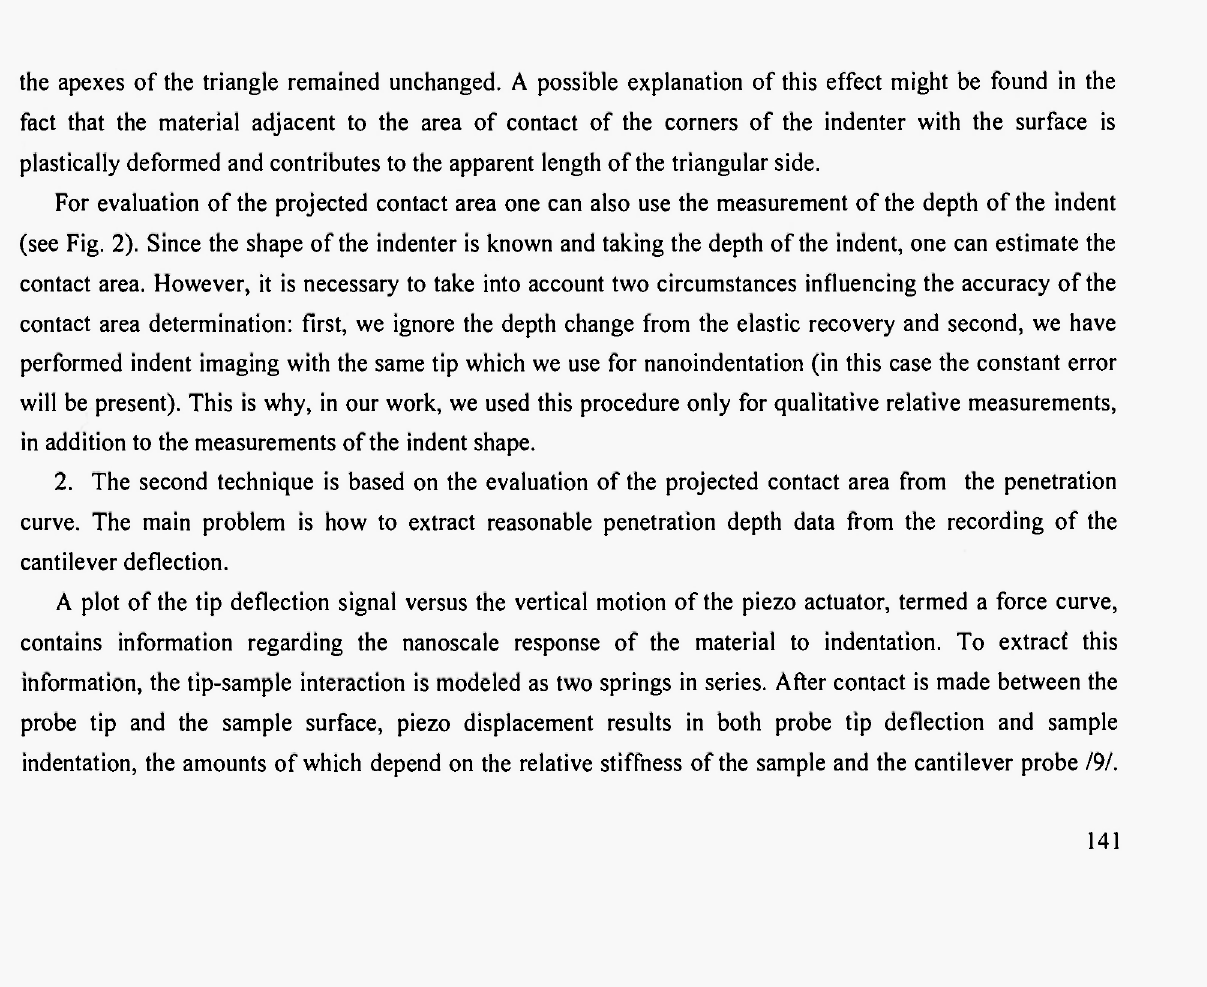
Fig. 2: Measurement of the indent depth. The vertical distance is a an indent